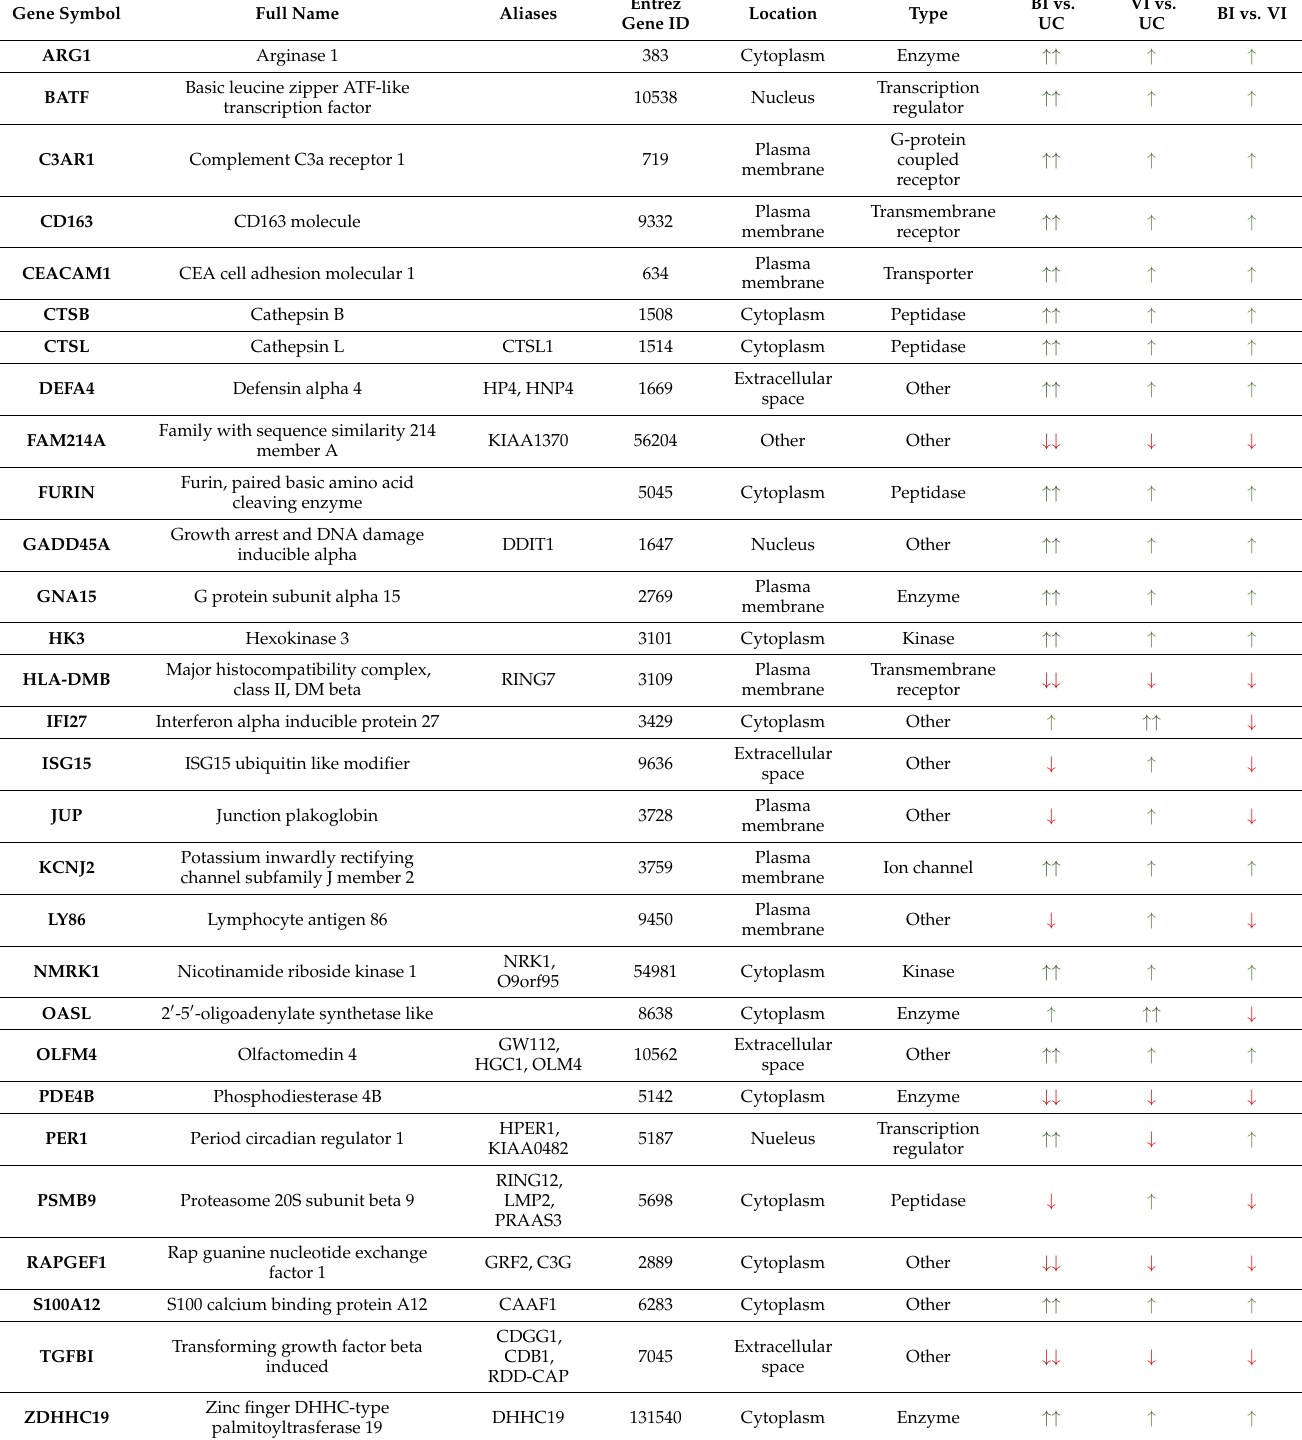
Table 5. Key information of the 29 mRNAs used in InSep test. Gene symbol, full names, aliases, entrez gene ID, location, and type are given for each of the 29 mRNAs, together with the directionality and relative change in three comparison pairs: bacterial infection vs. uninfected control (BI vs. UC), viral infection vs. uninfected control (VI vs. UC), and bacterial infection vs. viral infection (BI vs.